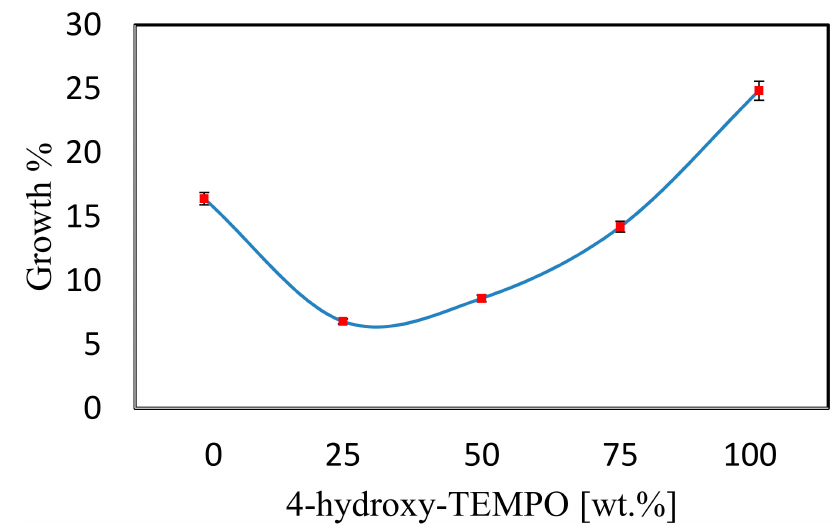
Figure 12. The e ff ect of DTMBP / 4-hydroxy-TEMPO concentration on the growth